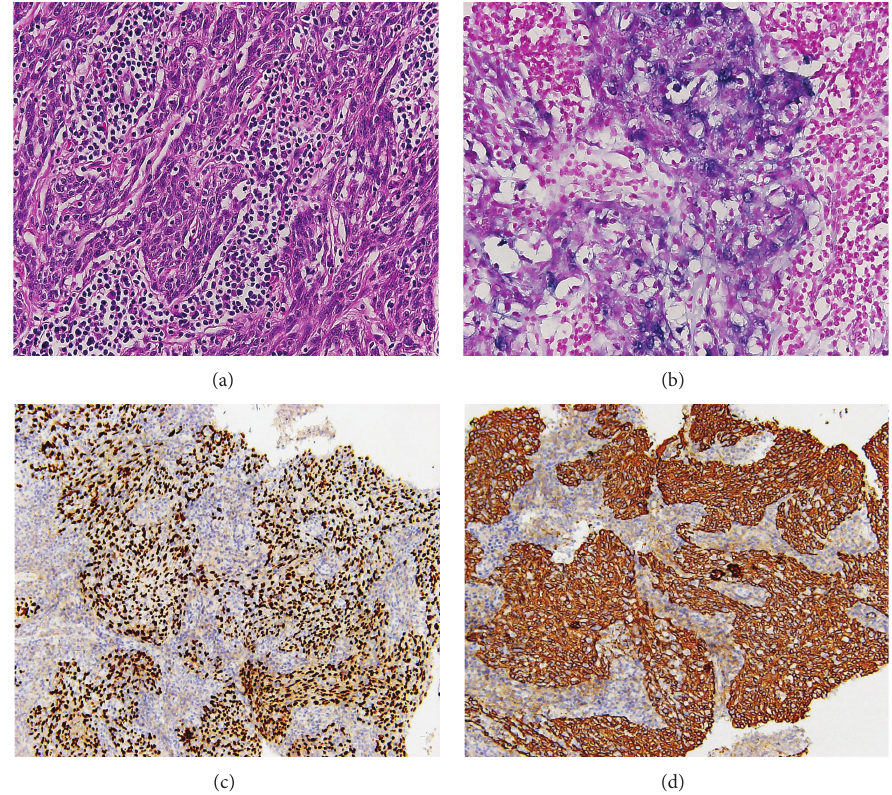
Figure 2: (a) Hematoxylin- and Eosin-stained cell block section shows non-small cell carcinoma consisting of syncytial tumor cells with focal necrosis and lymphocytic infiltrate in the background (original magnification, × 400); (b) The immunohistochemical study: EBER(+) (original magnification, × 400); (c) The immunohistochemical study: P63(+) (original magnification, × 200); (d) The immunohistochemical: CK(+) (original magnification, ×